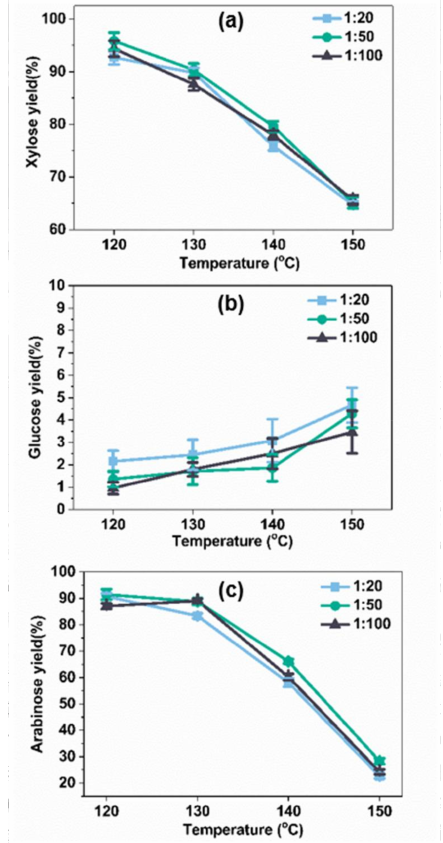
Figure 3. The effect of the solid–liquid ratio and temperature on sugar yields (oxalic acid 0.4 mol/L, 10 min, ( a ) xylose yield; ( b ) glucose yield; ( c ) arabinose